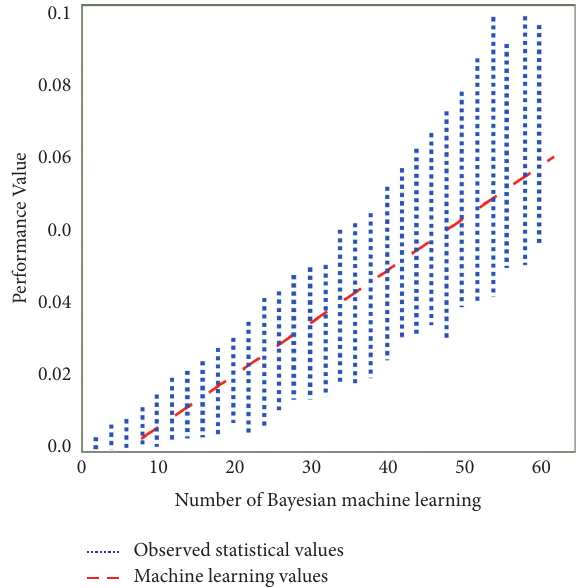
Figure 10: Training values and observation statistics of Bayesian model in machine